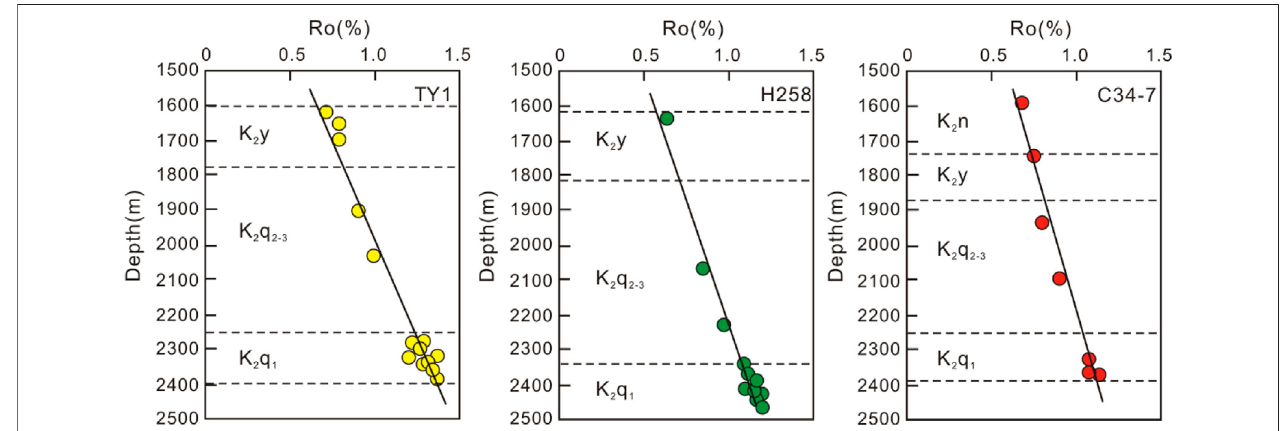
FIGURE 5 | Vitrinite re fl ectance (%Ro) vs. depth of three typical wells in the southern part of the Songliao Basin.